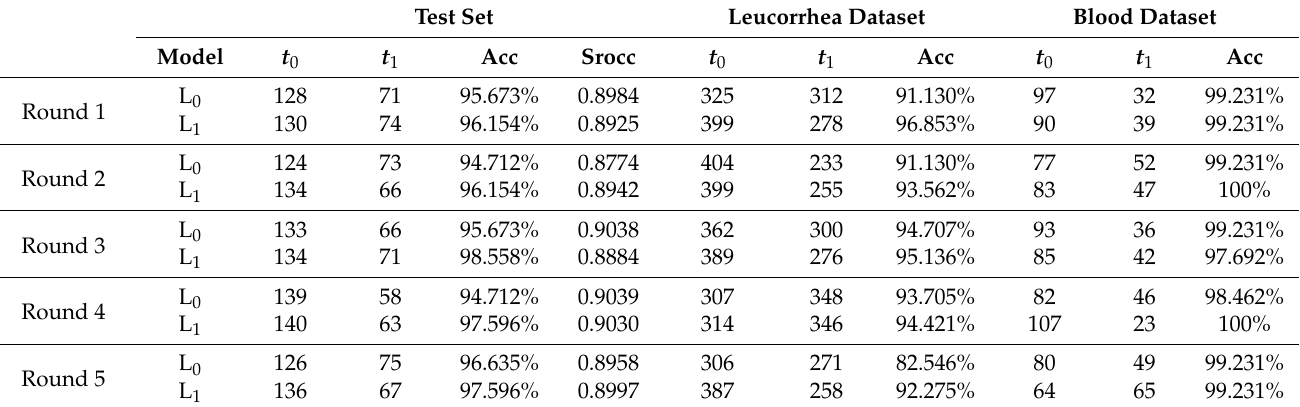
Table 1. The model performance on test set, leucorrhea dataset, and blood dataset. Test Set Leucorrhea Dataset Blood